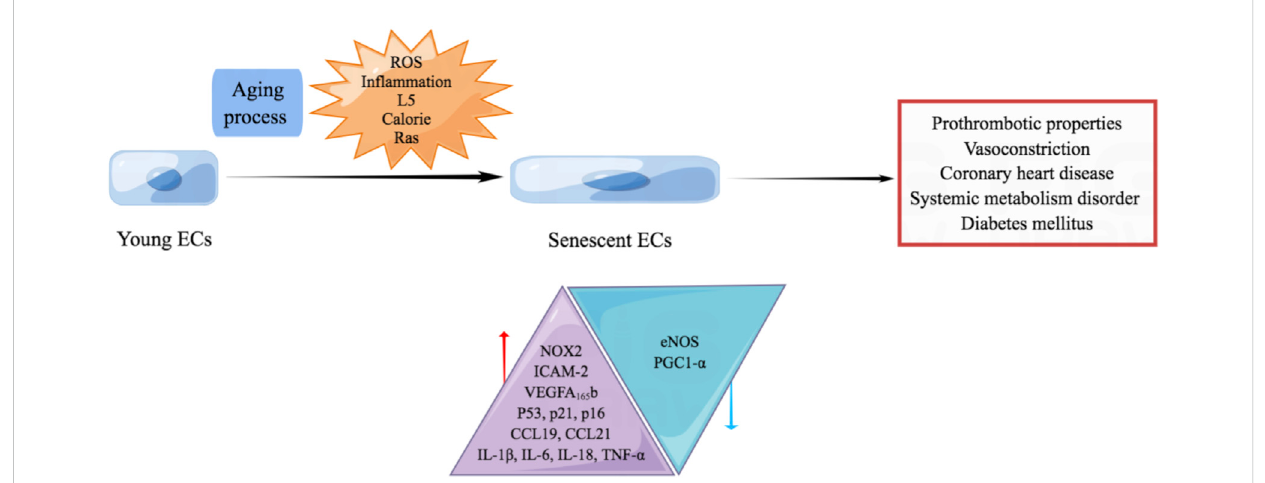
FIGURE 3 Endothelial senescence promotes aging-related CVD. Senescent ECs which are occurred during aging process or caused by ROS, chronic low- grade sterile in fl ammation, L5, excessive calorie and Ras are reported to possess prothrombotic, pro-oxidant, pro-in fl ammatory, and vasoconstrictor properties.SenescentECspromotetheoccurrenceofcoronaryheartdisease,systemicmetabolismdisorderanddiabetesmellitus.SenescentECsexhibit increased NOX2, ICAM-2, VEGFA 165 b, p53, p21, p16, CCL19, CCL21, IL-1 β , IL-6, IL-18, and TNF- α . Meanwhile, decreased eNOS and PGC1- α are observed in senescent